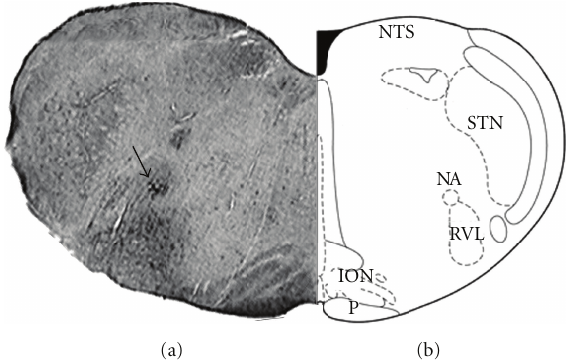
Figure 1: Typical microinjection site in the RVLM evaluated by 100nL of Evans blue di ff usion (a) and schematic representation (b). CST indicates corticospinal tract; ION: inferior olivary nucleus; NA: nucleus ambiguous; NTS: nucleus of the tractus solitari and STN: spinal trigeminal nucleus and P, Pyramid. The arrow indicates nucleus